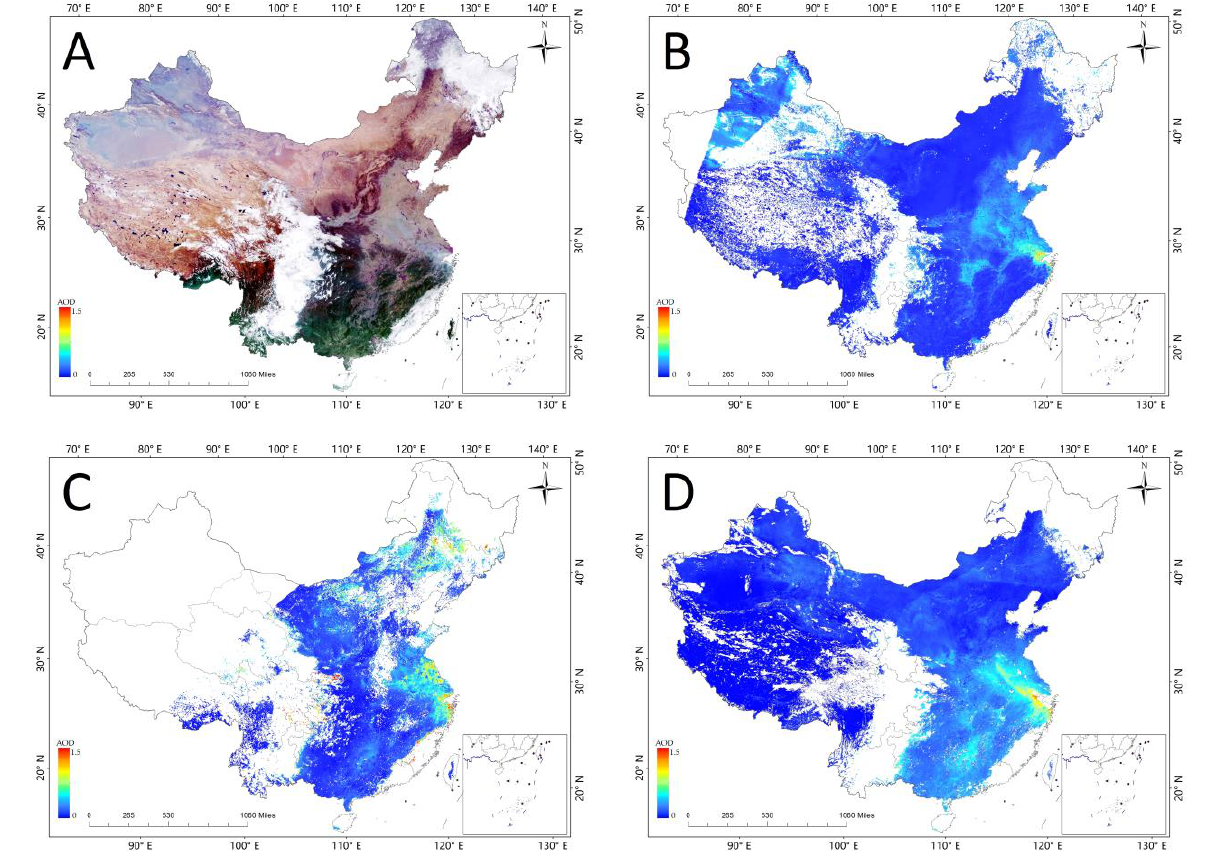
Figure 9. AHI true-color RGB images ( A ), DNN-estimated AHI AOD ( B ), AHI AOD product ( C ) and MODIS AOD product ( D ) over China at 2:00 on 8 November